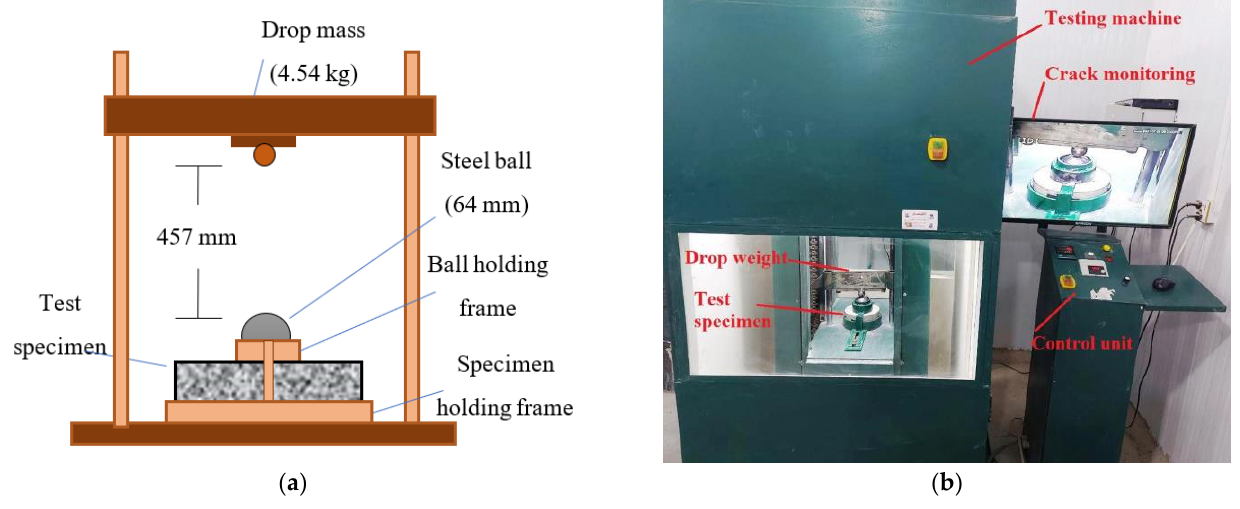
Figure 2. The drop-weight impact test; ( a ) schematic diagram of the test setup; ( b ) the automatic testing machine.